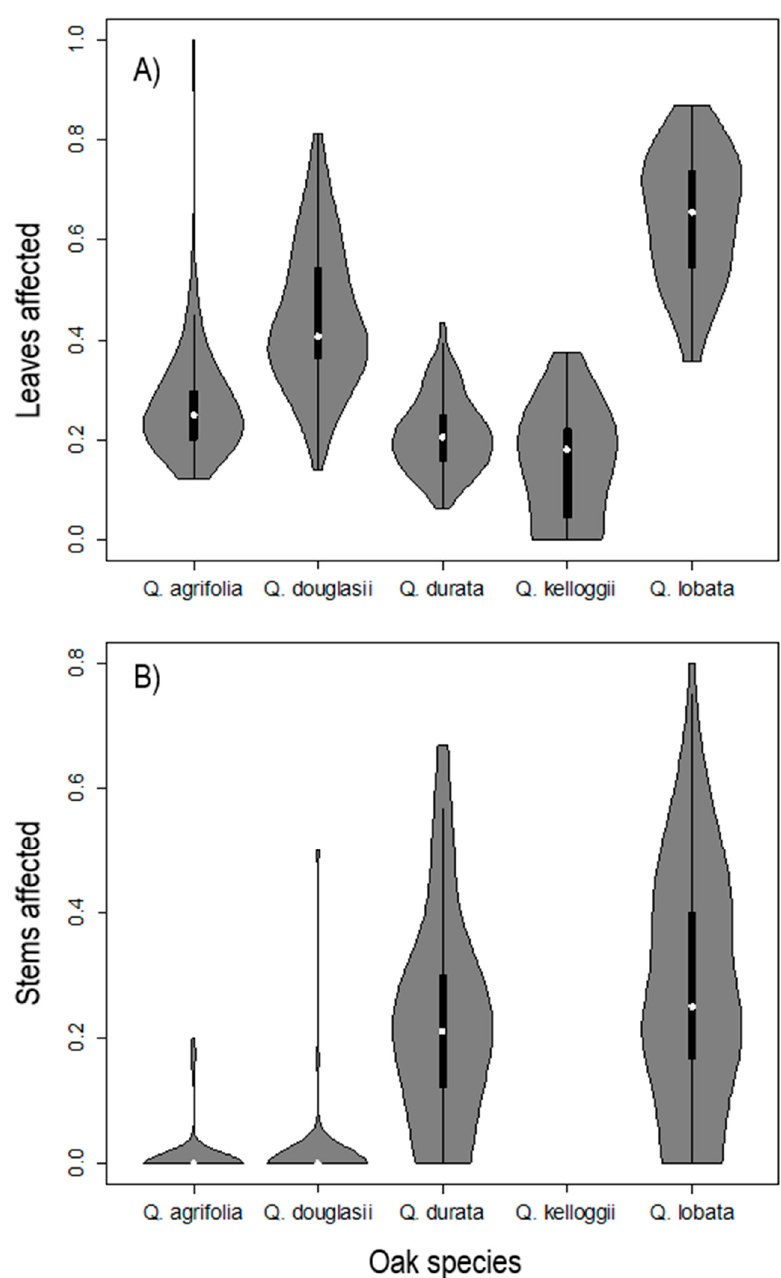
Figure 2. Violin plots showing the probability of gall incidence for leaves ( A ) and stems ( B ) of the five sympatric oak species at Jasper Ridge Biological Preserve, Northern California, USA. The violin plots show the median values of the data (white dot) with a box indicating the interquartile range and a rotated kernel density plot on each